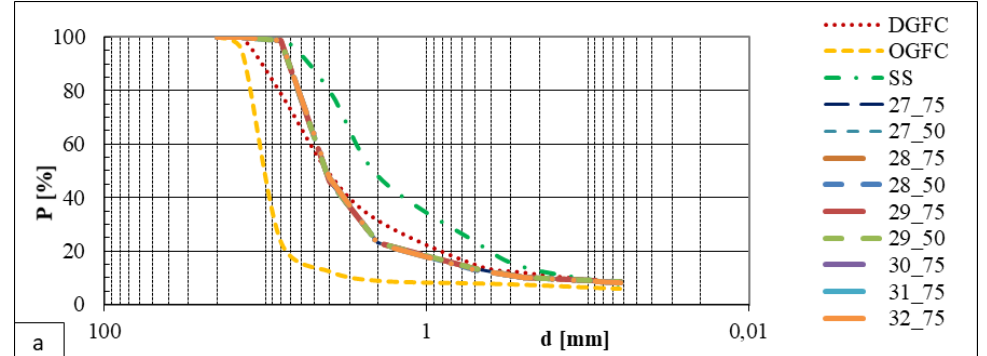
curve (a), Superpave gyratory compactor (b), Impulse hammer (c), Airflow resistance meter (d), Corelok (e), Skid resistance tester (f), Sand